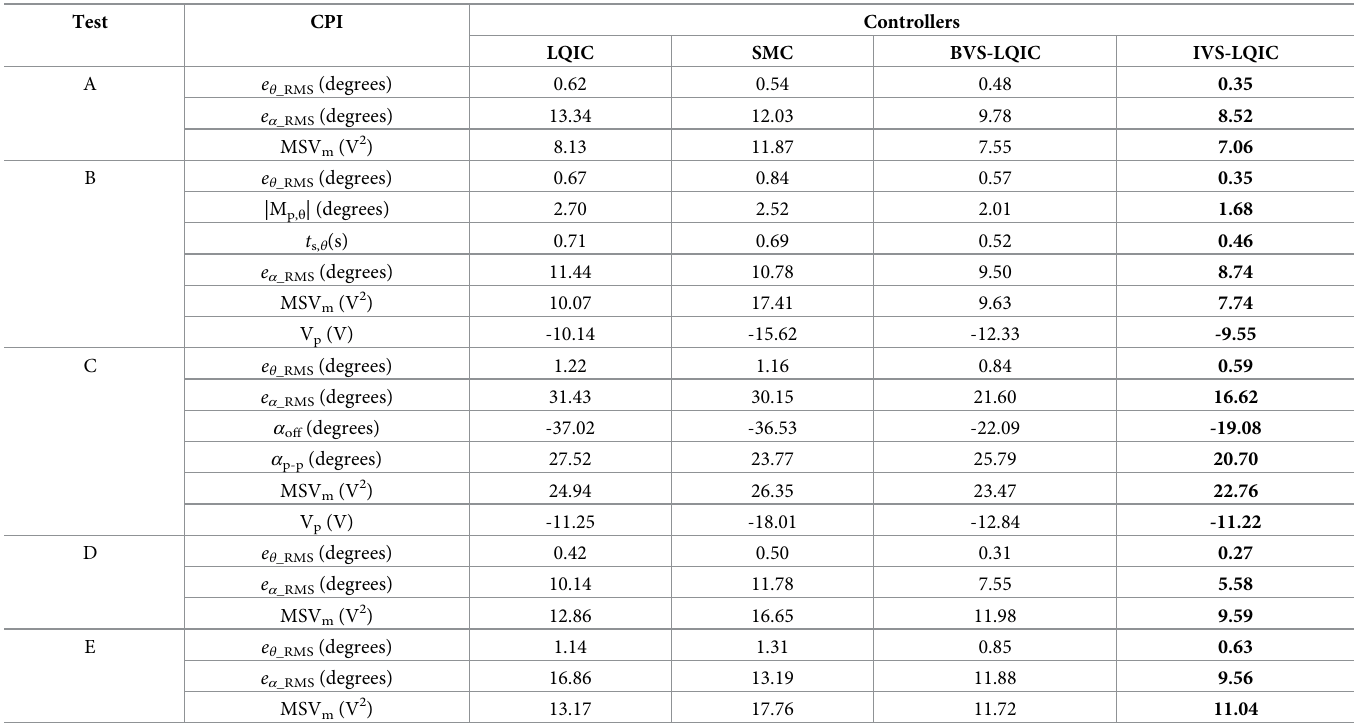
Table 2. Summary of experimental